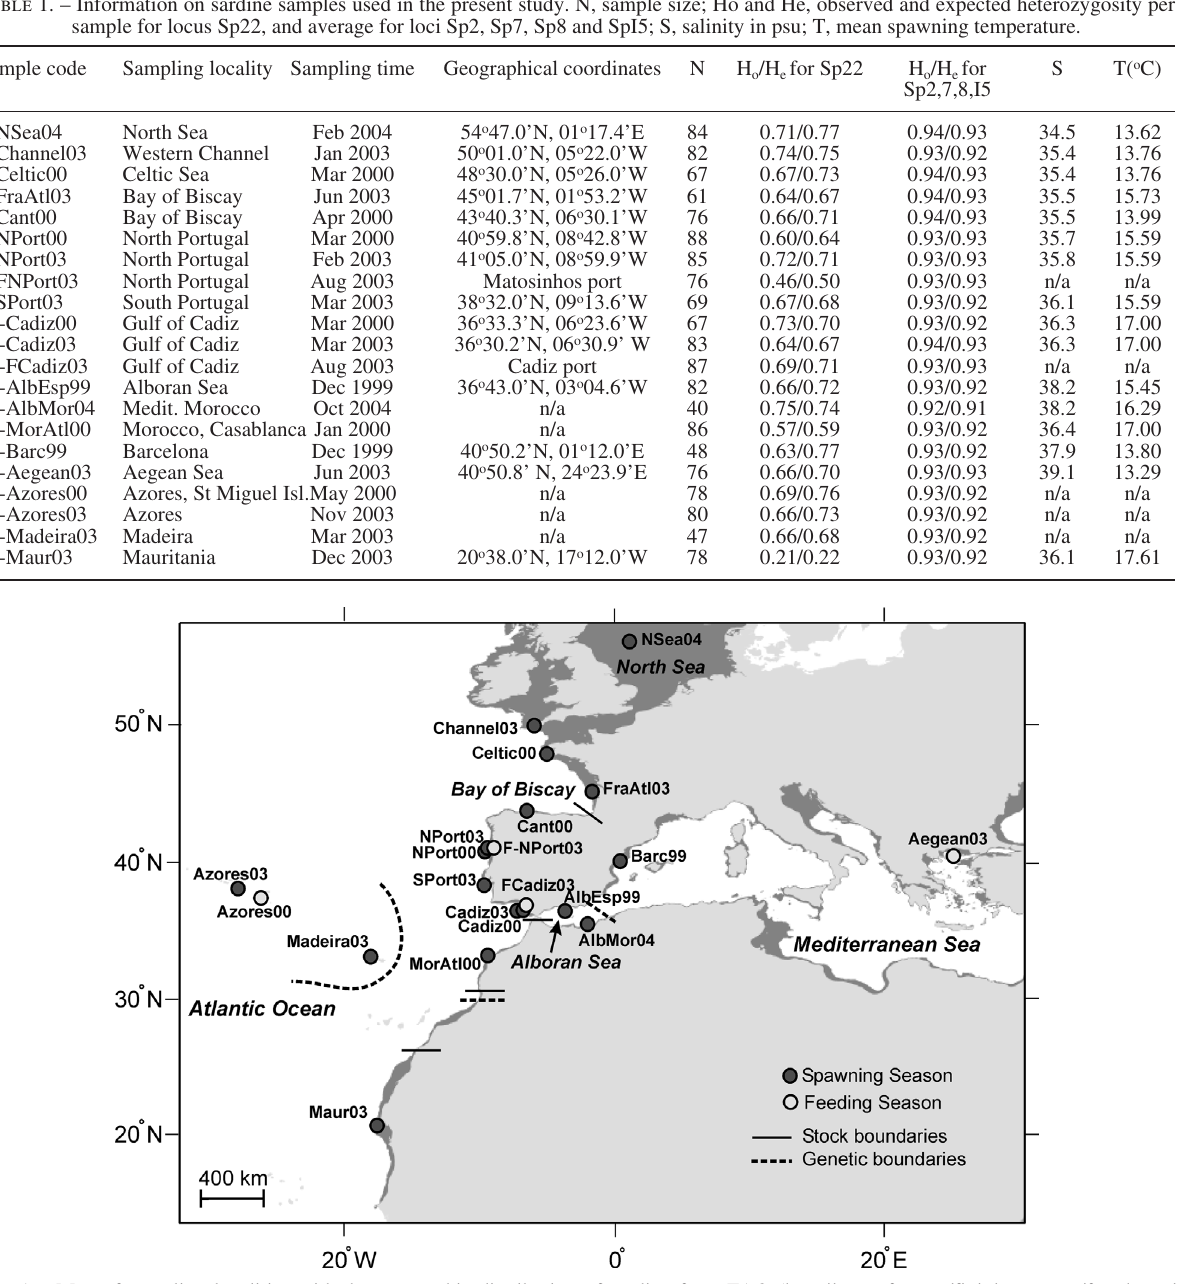
Fig . 1 – Map of sampling localities with the geographic distribution of sardine from FAO (http://www.fao.org/figis/geoserver/factsheets/ species.html). Sample abbreviations are as in Table 1. Stock boundaries in the Atlantic are indicated, as are the genetic boundaries identified in this study and in Chlaida et al.